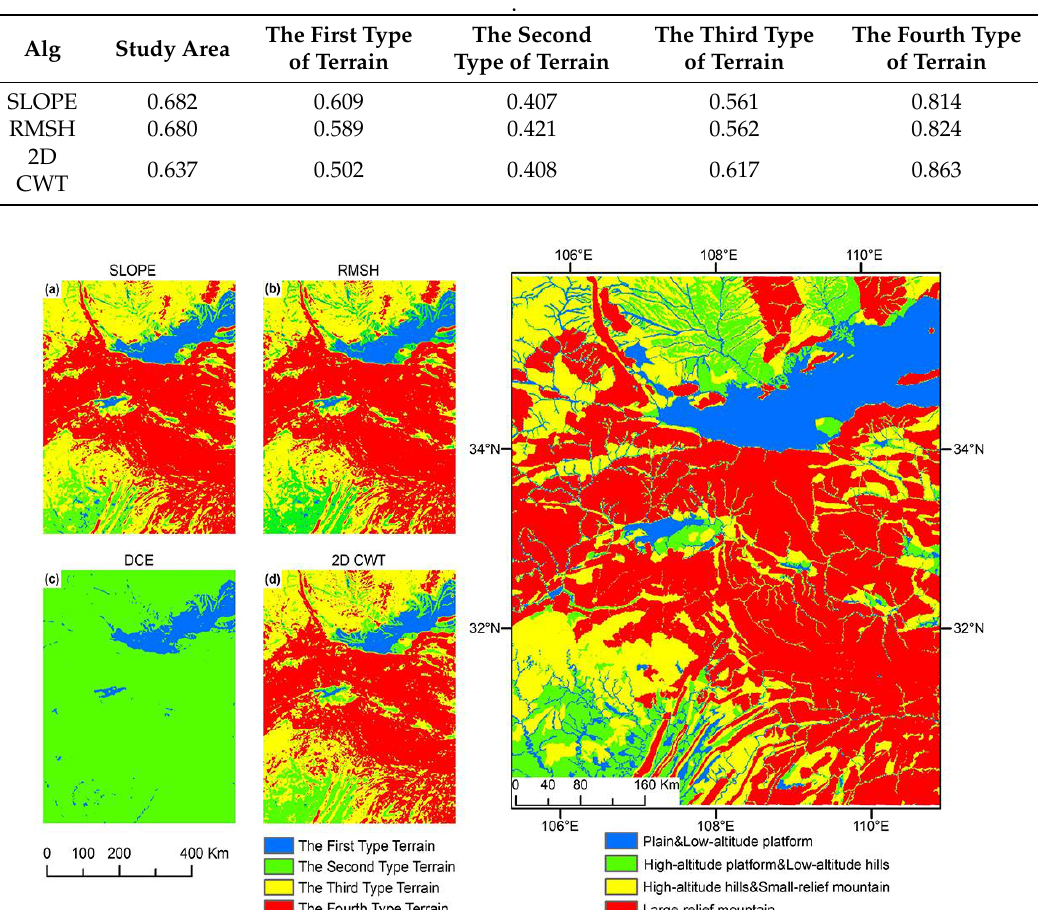
Table 4. Comparison of the terrain partition results to geomorphologic maps from different roughness algorithms